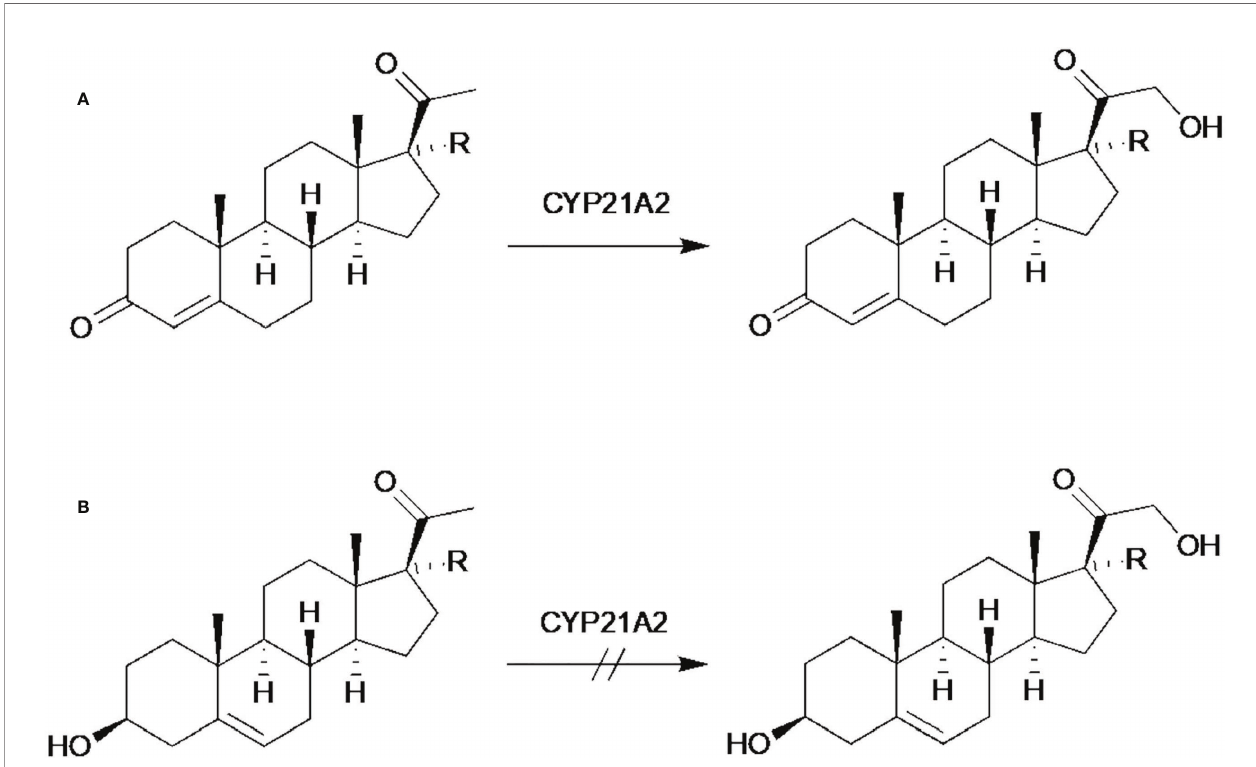
FIGURE 4 | A-ring structure dependent hydroxylation of progestogens (A) successful hydroxylation of 3-keto steroids (R = H = progesterone; R = OH = 17 a - hydroxyprogesterone), (B) no hydroxylation of 3-hydroxy steroids (R = H = pregnenolone; R = OH = 17 a